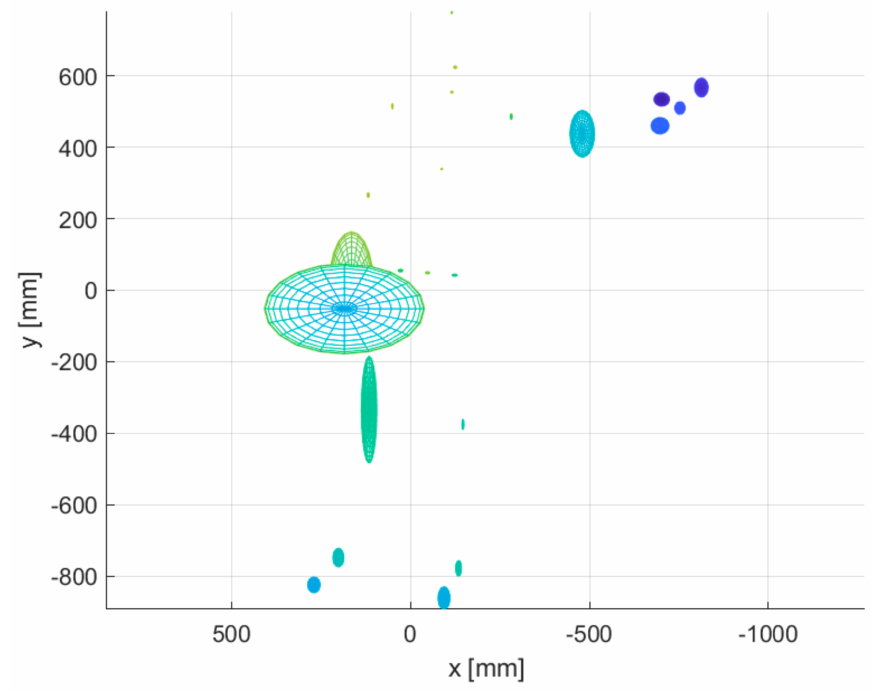
Figure 21. Body joint noise of Kinect v2.